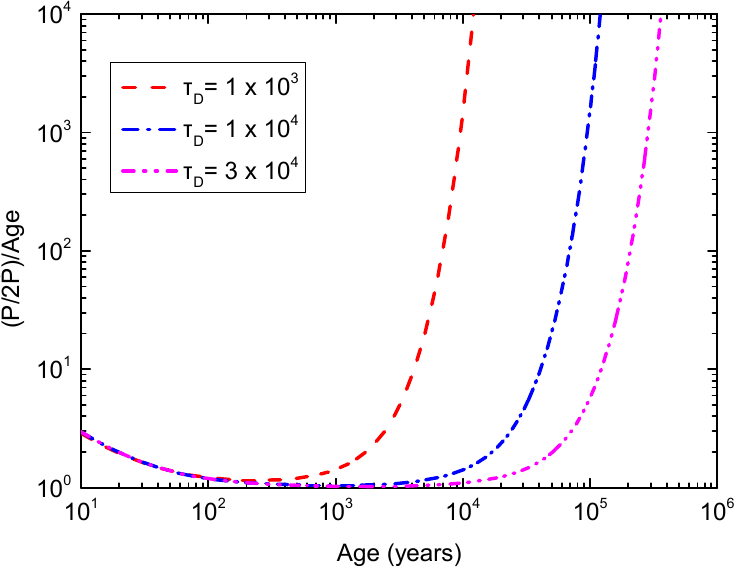
Figure 5. Estimated spin-down age P / ( 2 ˙ P ) over the true age of the pulsar as estimated for the magnetic field evolutions of Figure